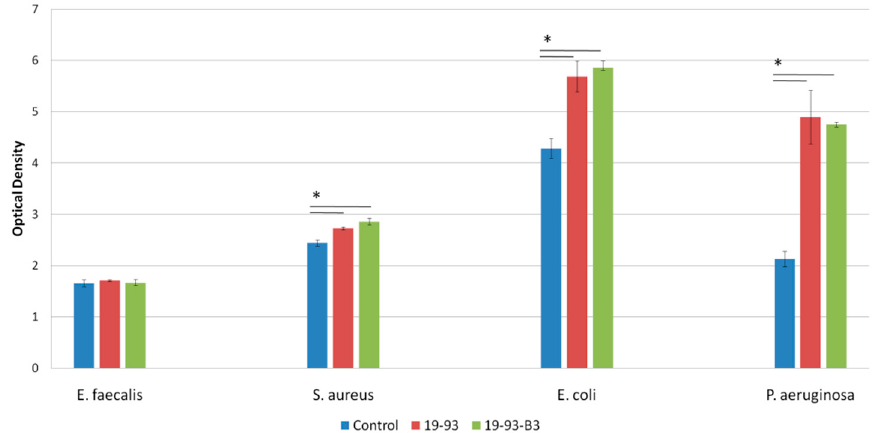
Figure 7. Antibacterial test carried out on 13-93 and 13-93-B3 BG coated Ti compared with the control sample, reported as optical density measured at 600 nm (obtained values are multiplied by the dilution factor), expressed as mean values ± standard deviation of 3 independent experiments. Statistical analysis was performed through ANOVA, followed by post hoc Tukey test (* p < 0.05).